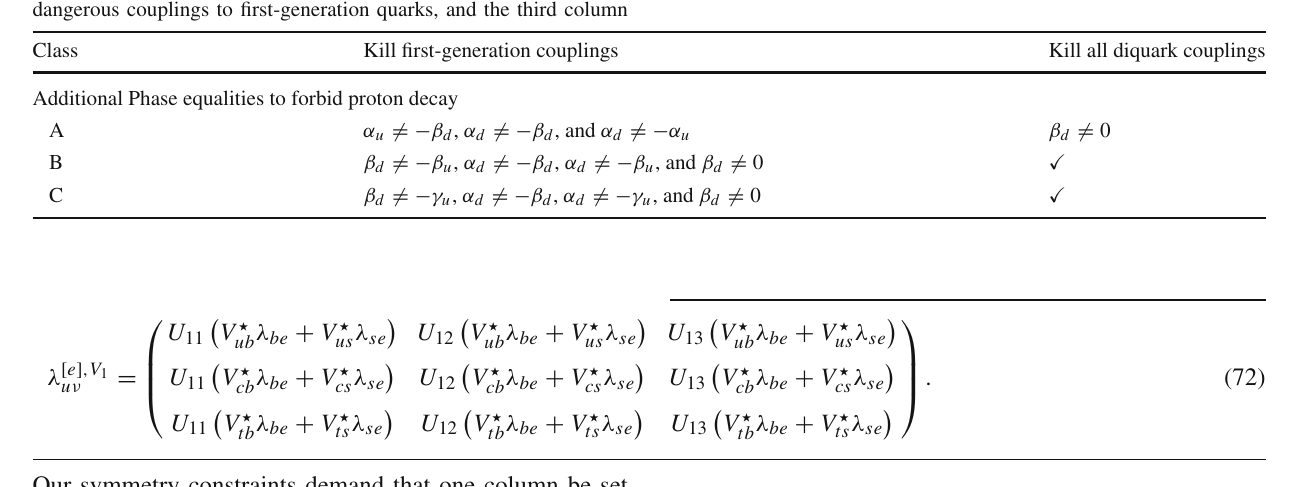
showswhat(ifany)additionalrelationshipsarerequiredtofullyremove the diquark operators from the